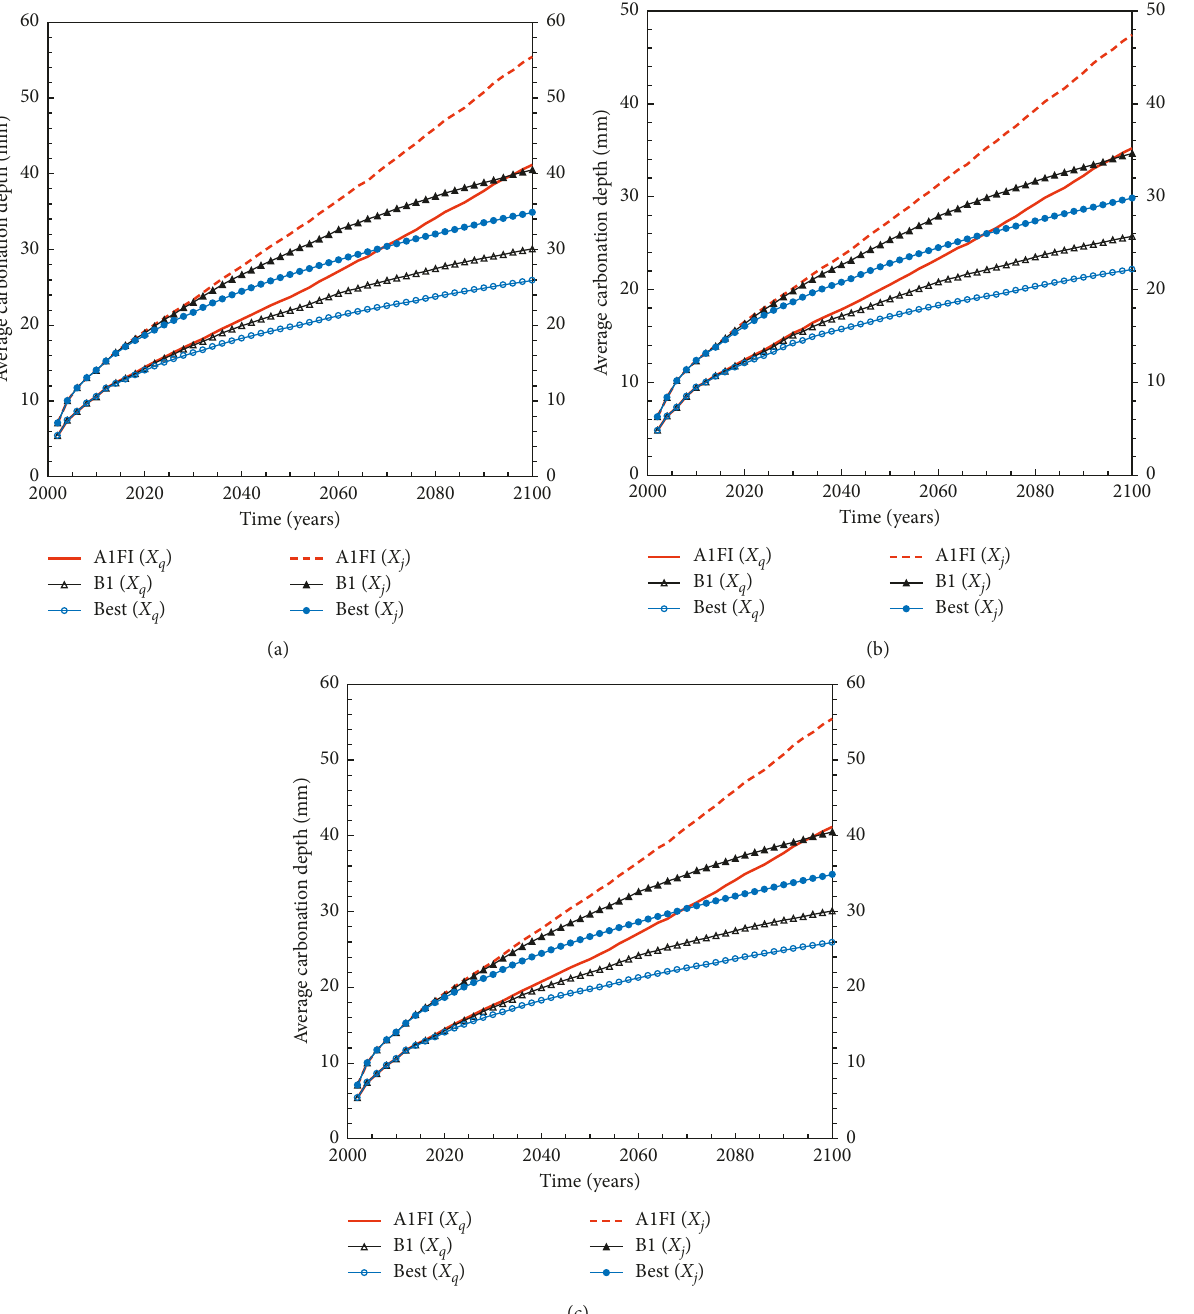
Figure 7: Carbonation depth: (a) C25 concrete; (b) C30 concrete; (c) C35 concrete.